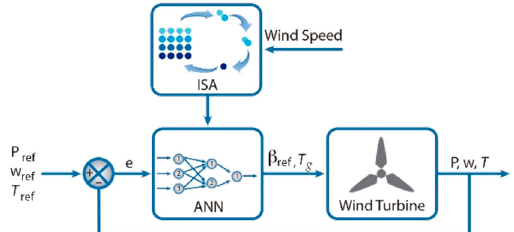
Figure 19. A PID controller is used to regulate the pitch angle and perform the MPPT; an ANN is used to adapt the PID gains in any state of the system [80].